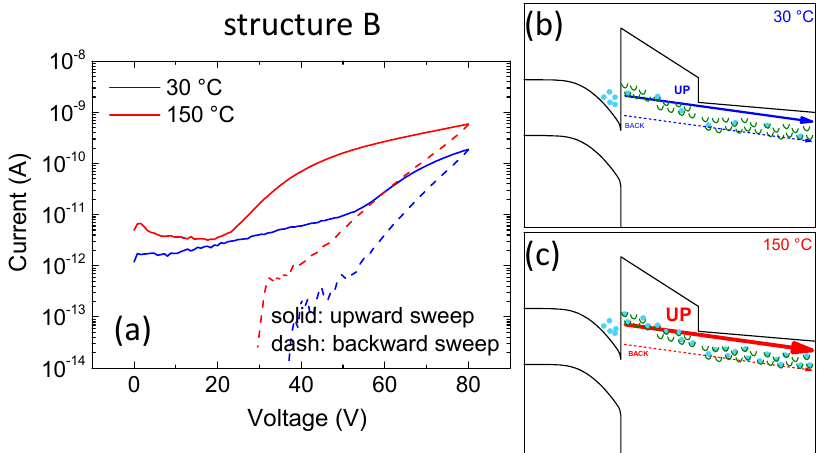
Figure 7. ( a ) Double sweep (upward: solid, backward: dashed) current-voltage characterization on the structure B at both room and high temperature. ( b , c ) represent a schematic band diagram at room and high temperature, respectively.